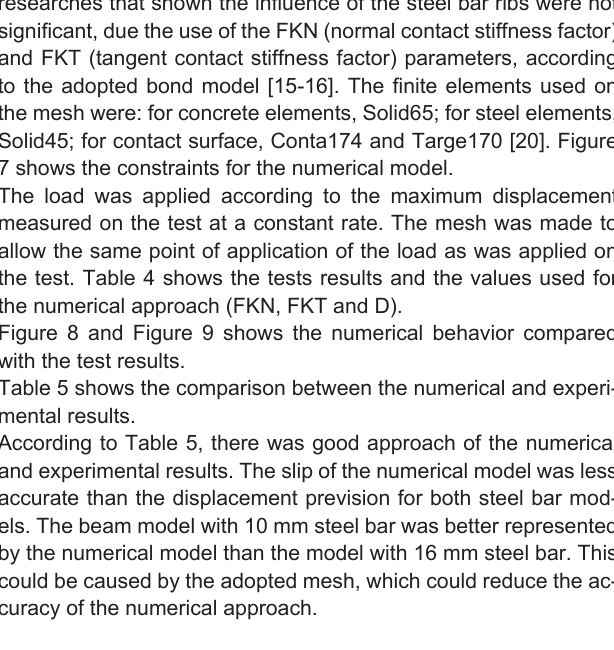
Table 3 – Specimens division for tests